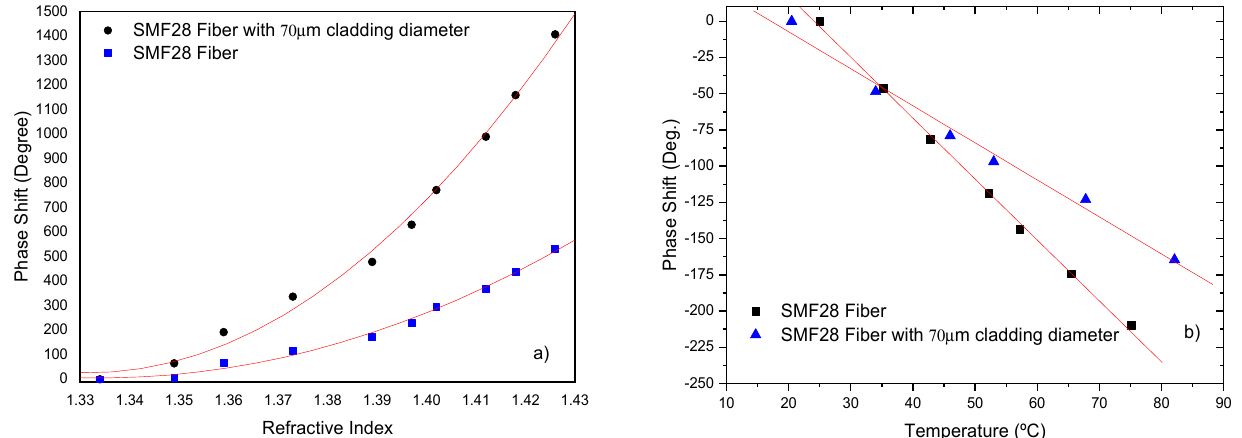
Figure 16. Interferometric phase changes for a 90 mm sensing length and two different sensing head fiber diameters of 125 µ m and 70 µ m, respectively: ( a ) to refractive index variations; ( b ) liquid temperature.